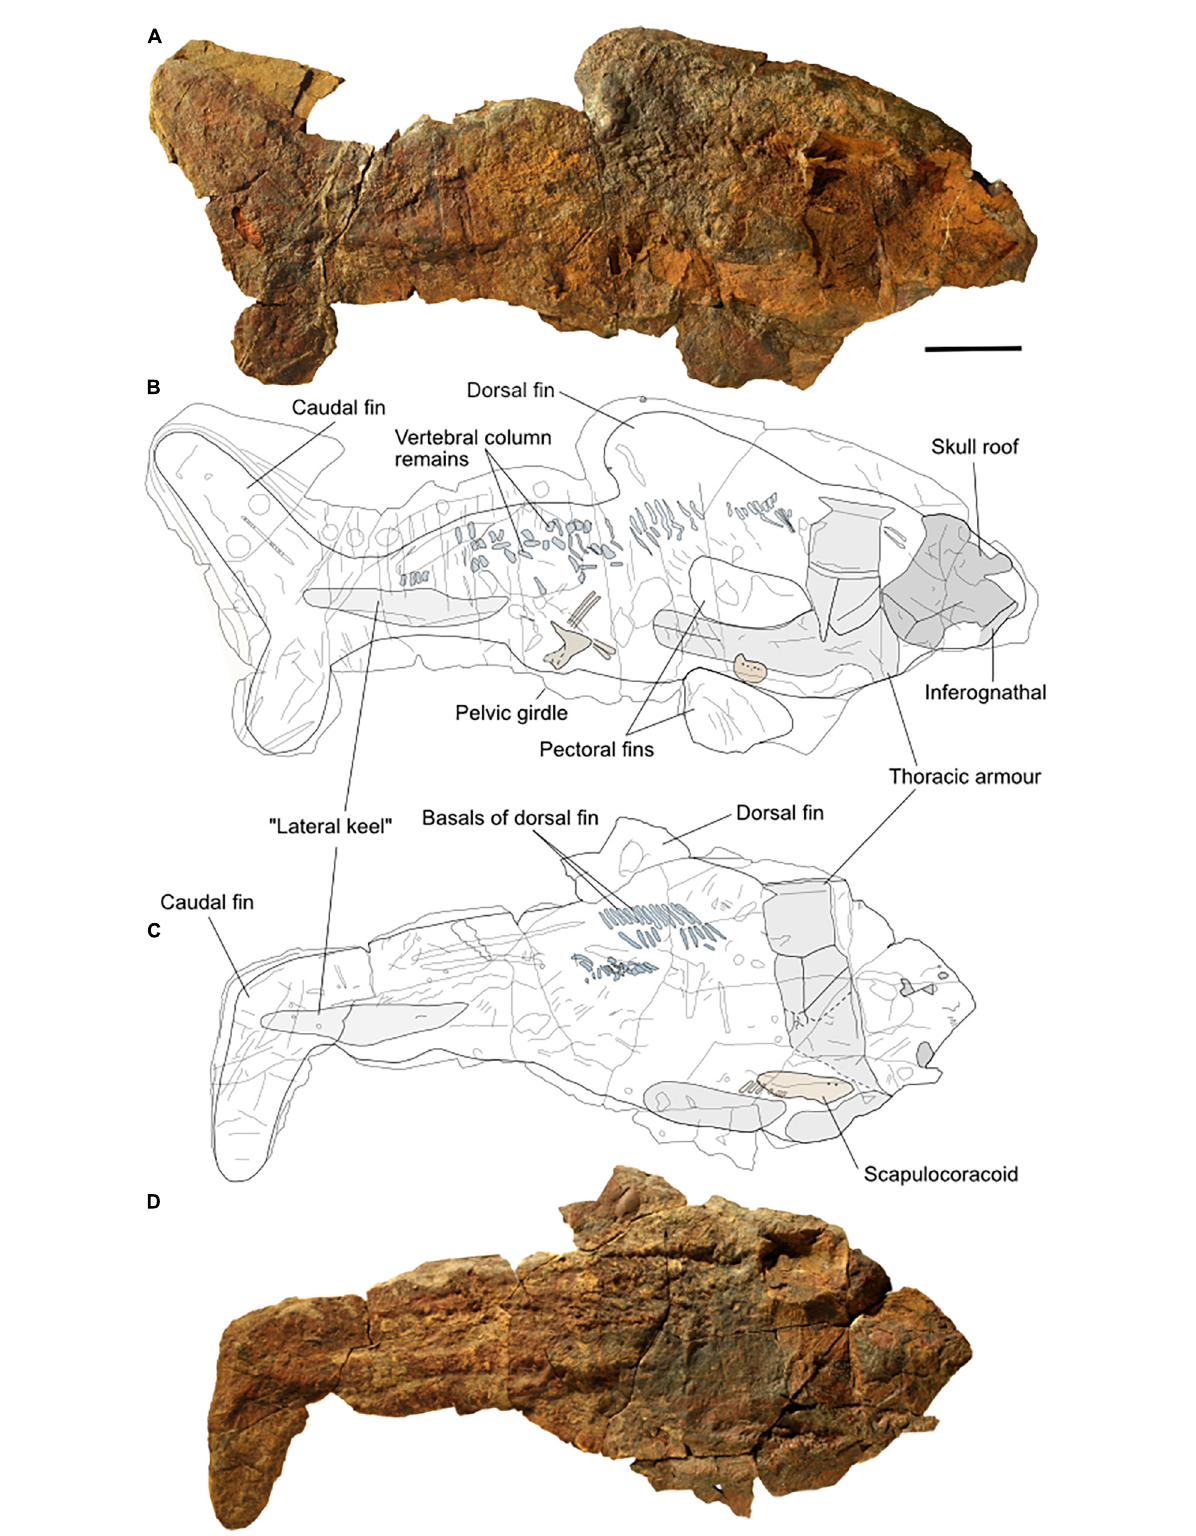
FIGURE2 Two main specimens of Amazichthys trinajsticae gen. et sp. nov. The holotype, AA.MEM.DS.8 (A) , and its line drawing (B) , and PIMUZ A/I 4773 and its line drawing (C,D) . The scale bar corresponds to 100 mm.